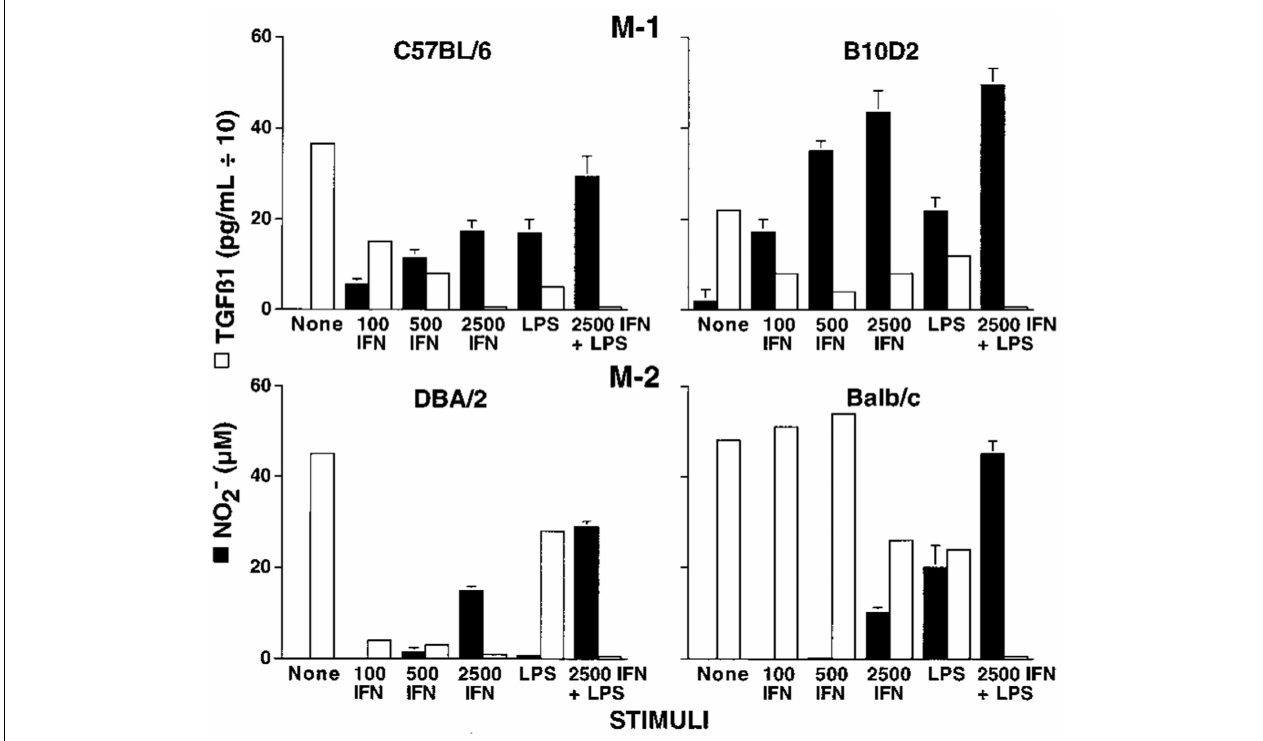
FIGURE 6 | Dominant NO production by C57B/6 macrophages compared to Balb/c macrophages . Also, NO production is inversely proportional to macrophage TGF- β production. From Ref. (16). Copyright 2000. The American Association of Immunologists, Inc.